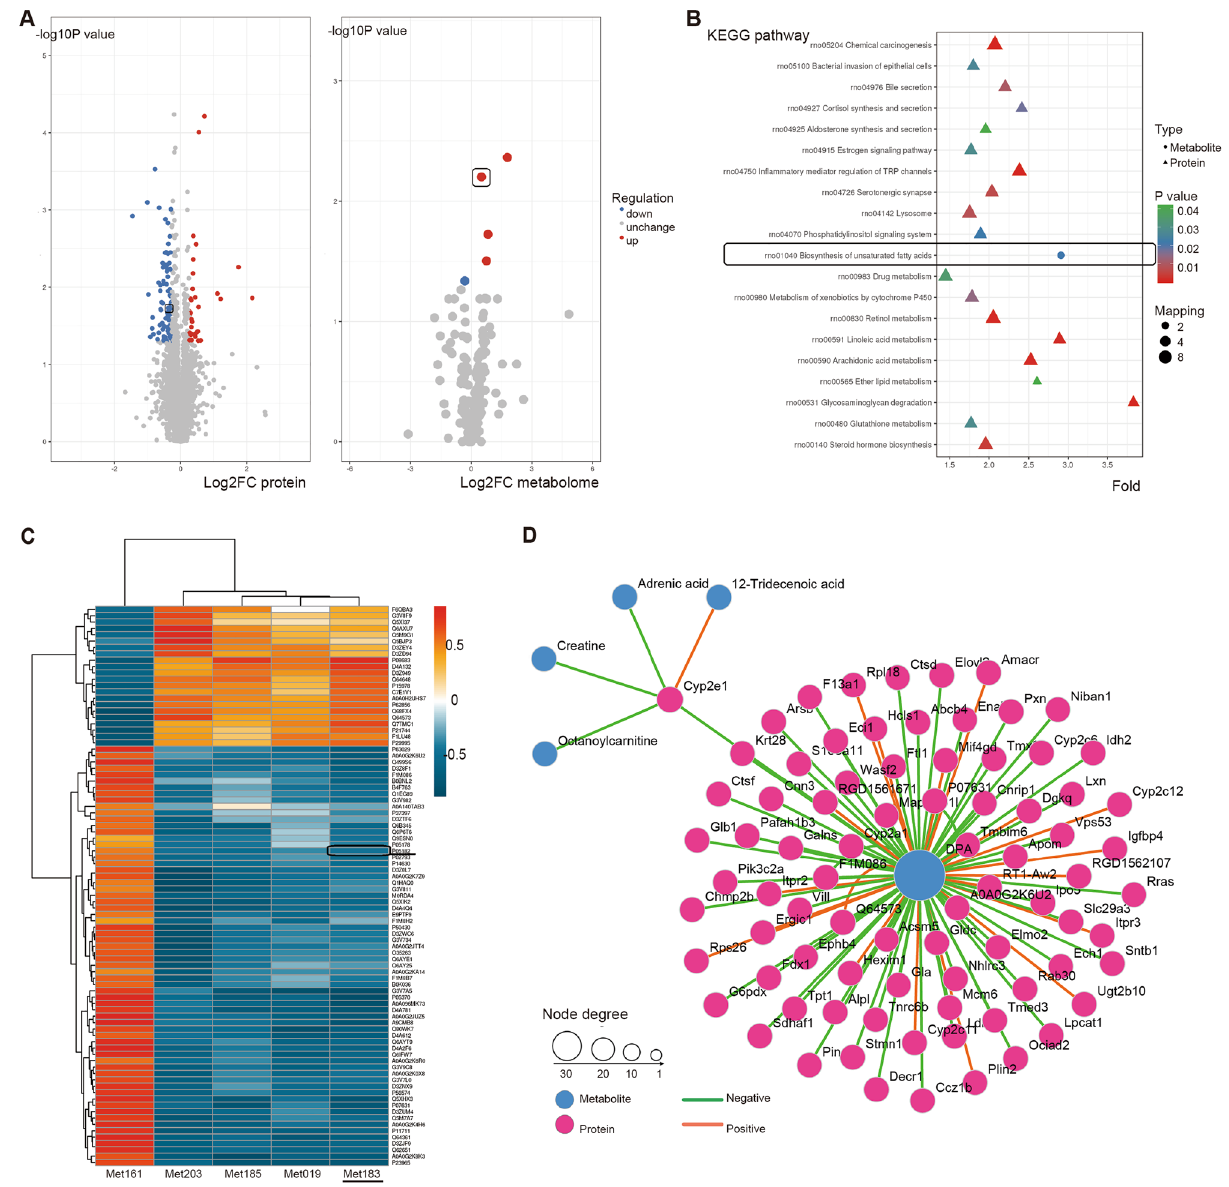
Figure 2. The integrative analysis of proteomics and metabolomics -based detection in rat livers from donation after cardiac death following static cold storage and normothermic machine perfusion (NMP). Cyp2e1 represents cytochrome P450 2E1 protein; DPA represents docosapentaenoic acid. ( A ) The volcano plot represents the results of the proteomics (left) and metabolomics (right) analysis between air-oxygenated and hyperoxygenated NMP. Red spots represent the upregulated proteins/metabolites; blue spots represent the downregulated proteins/metabolites; and grey spots represent the unchanged proteins/metabolites. The differentially expressed protein (CYP2E1) and metabolite (DPA) were identified and encircled. ( B ) The KEGG enrichment bubble chart shows the differentially expressed proteins (triangle) and metabolites (bubble) in the corresponding KEGG pathway. The color represents the degree of statistical significance. The size represents the number of the differentially changed proteins/metabolites in the corresponding pathways. The encircled pathways of biosynthesis of unsaturated fatty acids were identified to relate to CYP2E1 and DPA. ( C ) Heatmap of Spearman correlation analysis of significant proteins (y-axis) and metabolites (x-axis). Each color cell on the map corresponds to a Spearman correlation coefficient between the identified proteins (y-axis) and metabolites (x-axis). Red denotes positive correlation, whereas blue denotes negative correlation, and the dark color denotes the value of the Spearman correlation coefficient. The encircled pathway was shown as negatively correlated to relate with P05182 (CYP2E1) and Met183 (DPA). ( D ) Identified from proteomics and metabolomics, the protein-metabolite interaction network provides a visualization of the interaction between functionally related proteins indicated by the red circle and metabolites by the blue circle. Cyp2e1 may react with metabolites (Octanoylcarnitine, Creatine, Adrenic acid, 12-Tridecenoic acid and DPA) ; DPA lies in the center of the reacted proteins including